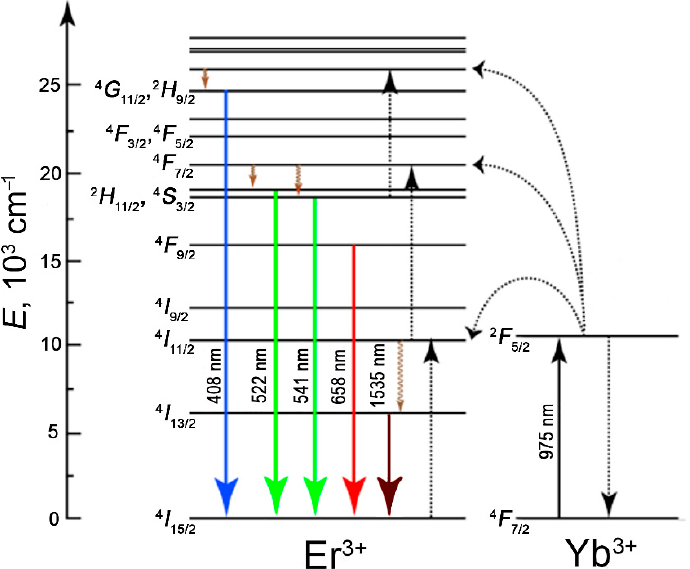
Figure 7. Simplified energy level diagram and possible up- and down-conversion luminescence mechanisms in BaY 2 F 8 crystals co-doped with Yb 3+ /Er 3+ ions.